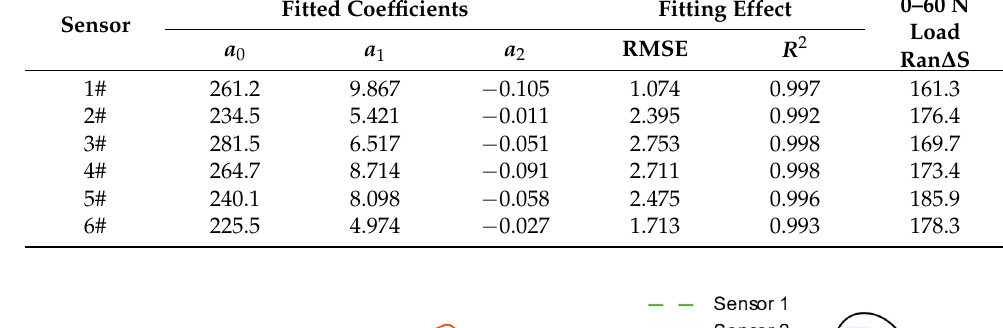
Table 1. Fitting Result of Sensing Unit Electrical Characteristic.